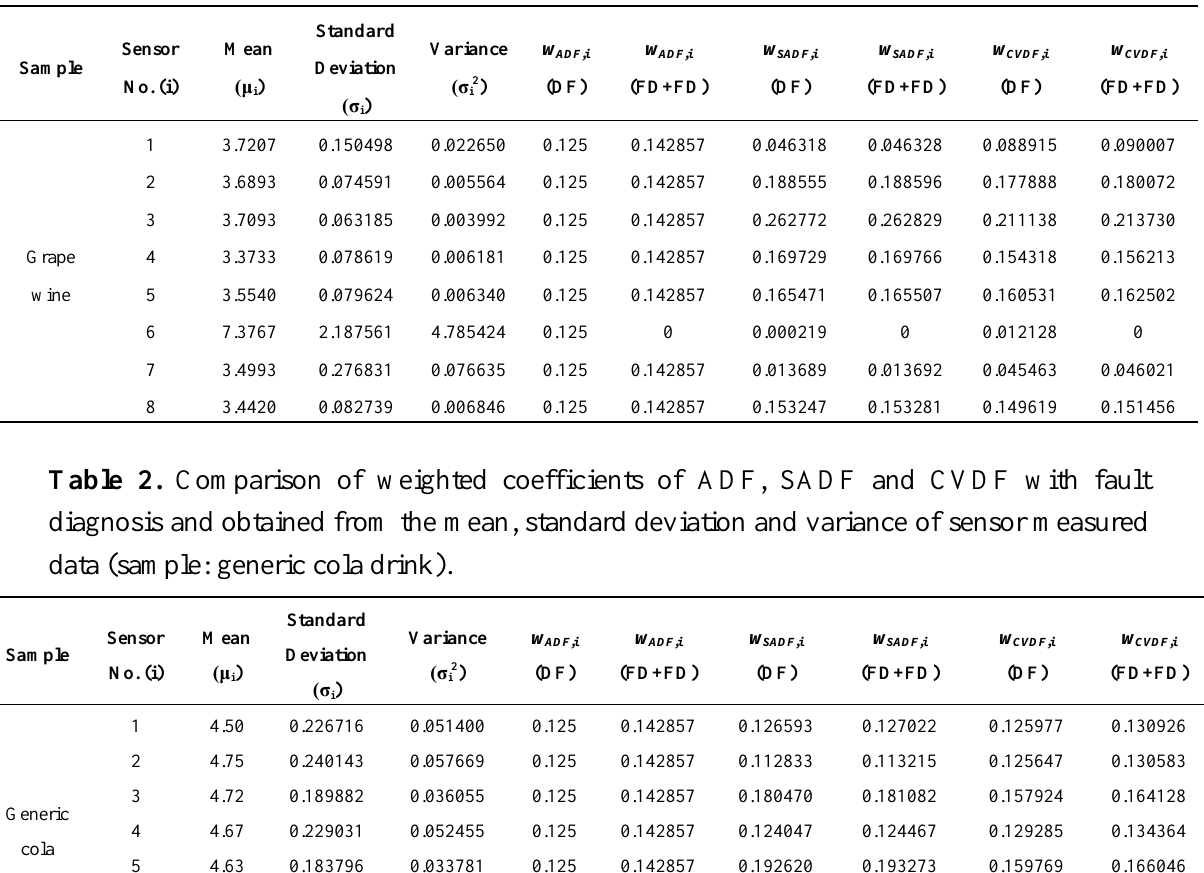
Table 1. Comparison of weighted coefficients of ADF, SADF and CVDF with fault diagnosis and obtained from the mean, standard deviation and variance of sensor measured data (sample: grape wine).